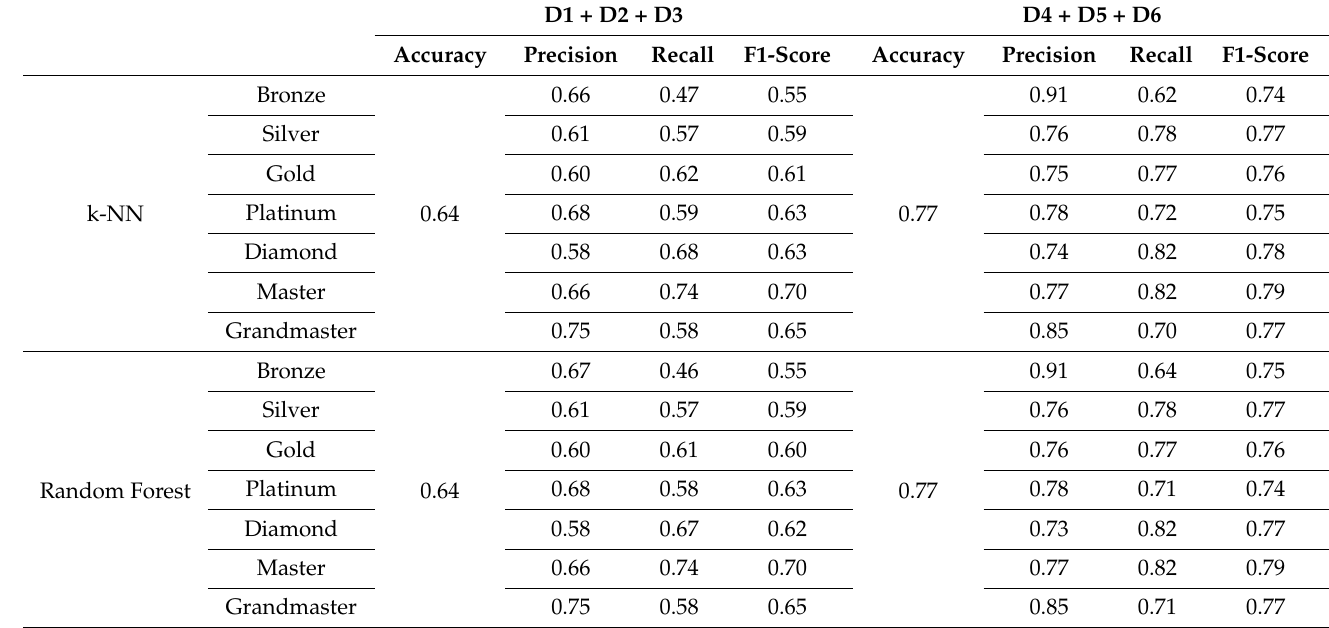
Table 4. Comparison of two groups. The first group contains D1, D2, and D3. The second group contains D4, D5, and